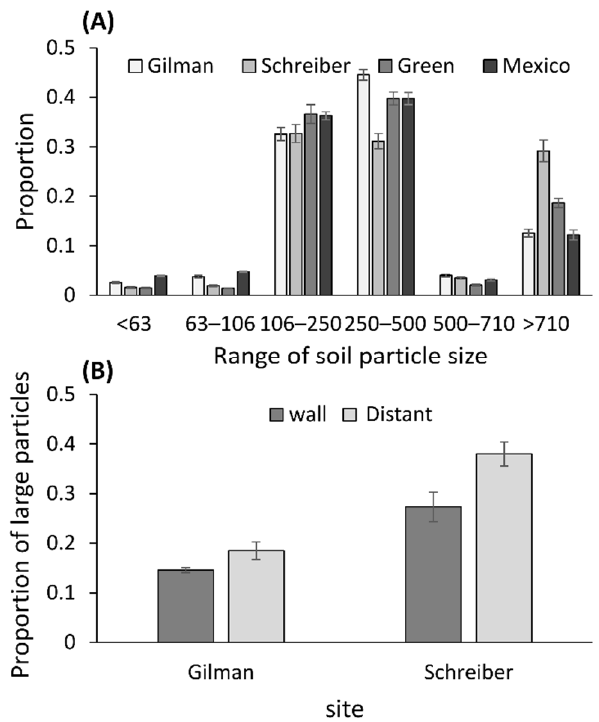
Figure 3. ( A ) The range of soil particles at four sites. ( B ) At two of the four study sites, the proportion of large particles at distant positions was higher than that next to walls. Means ± 1 SE are presented.